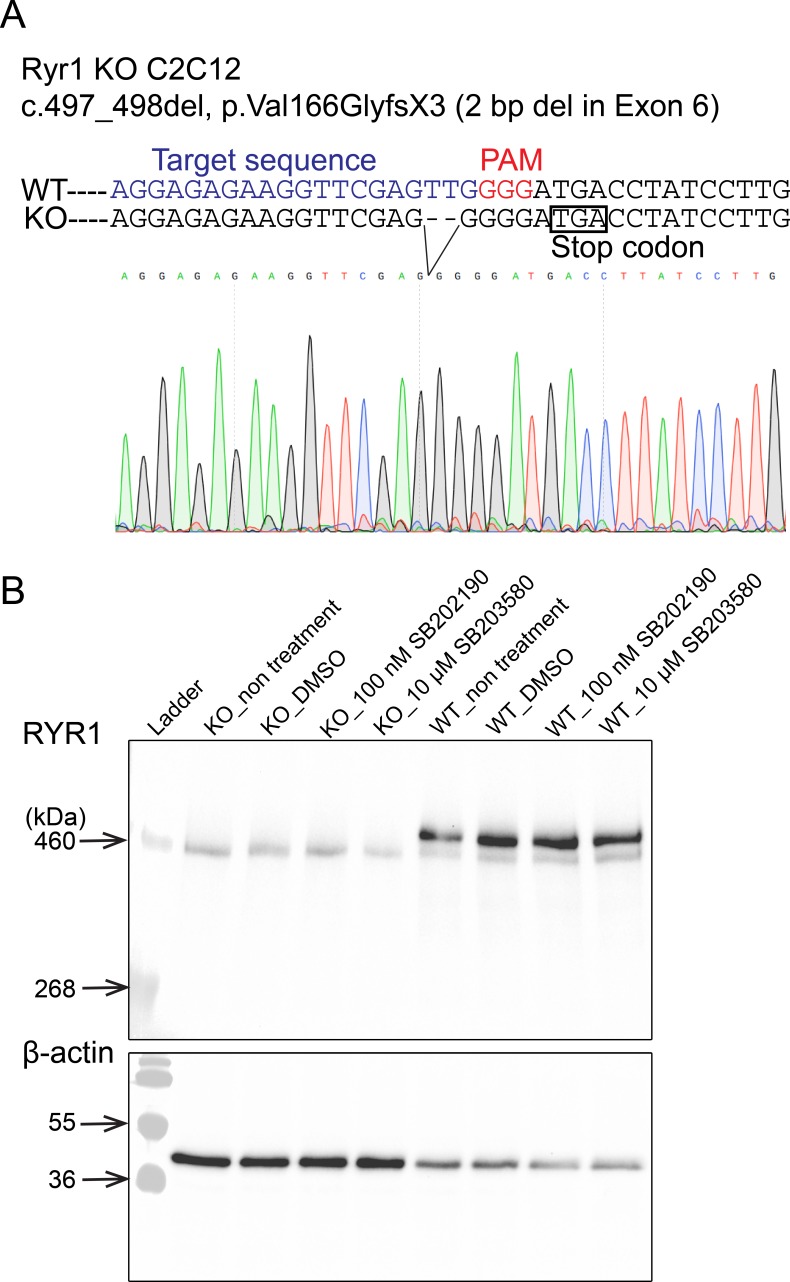
Characterization of Ryr1 knockout (KO) C2C12 cells.(A) DNA sequence of Ryr1 KO showing frameshift mutation and premature stop codon. (B) Western blotting analysis of RyR1 in C2C12 myotubes at after 5 days of differentiation.